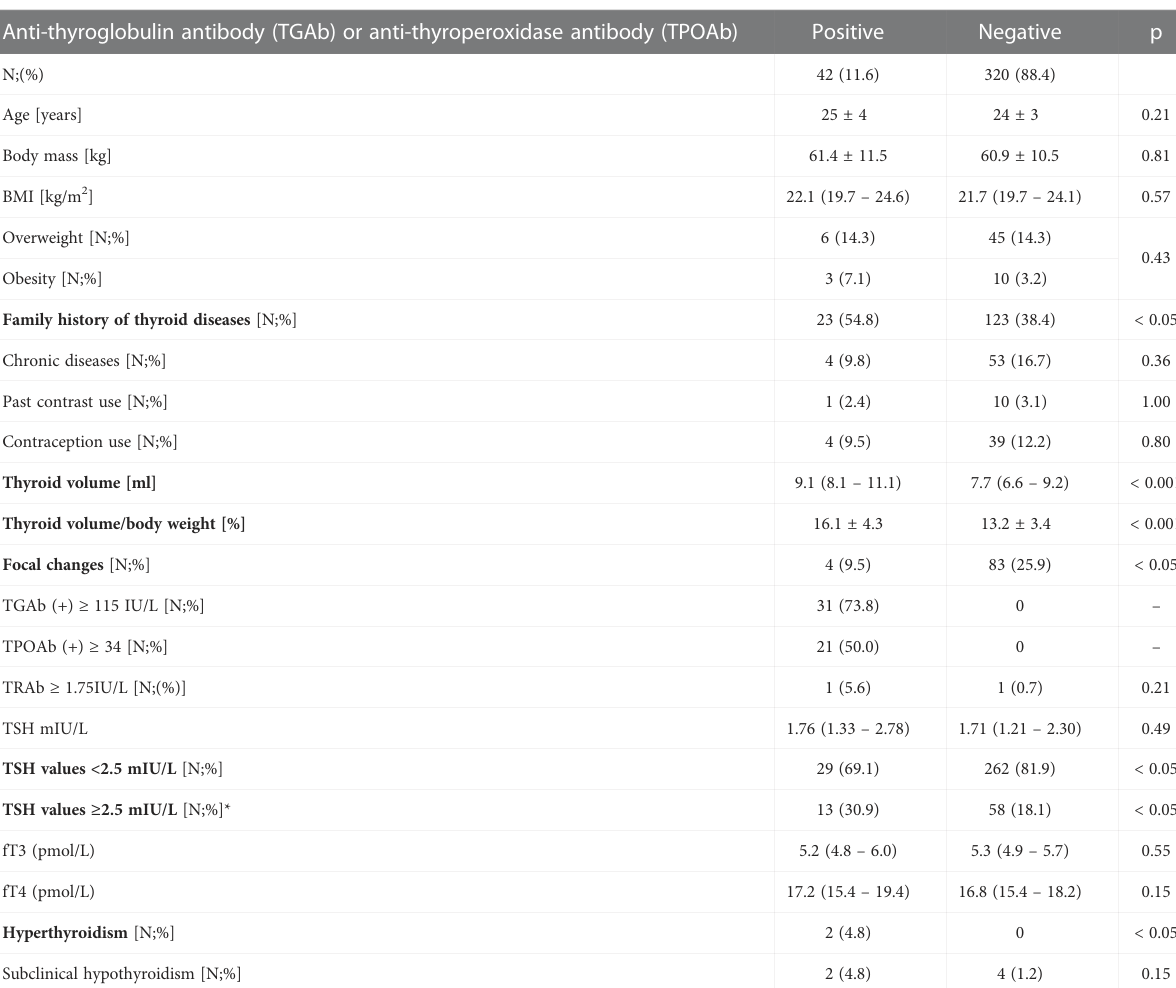
TABLE 2 The characteristics of subgroups according to the occurrence of anti-thyroid